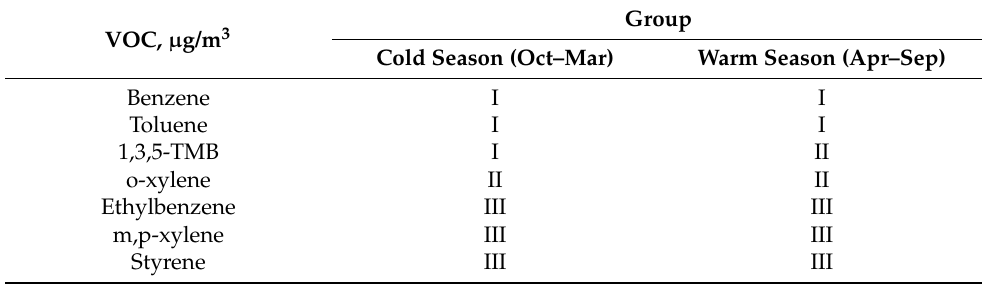
Table 6. Division of VOCs into